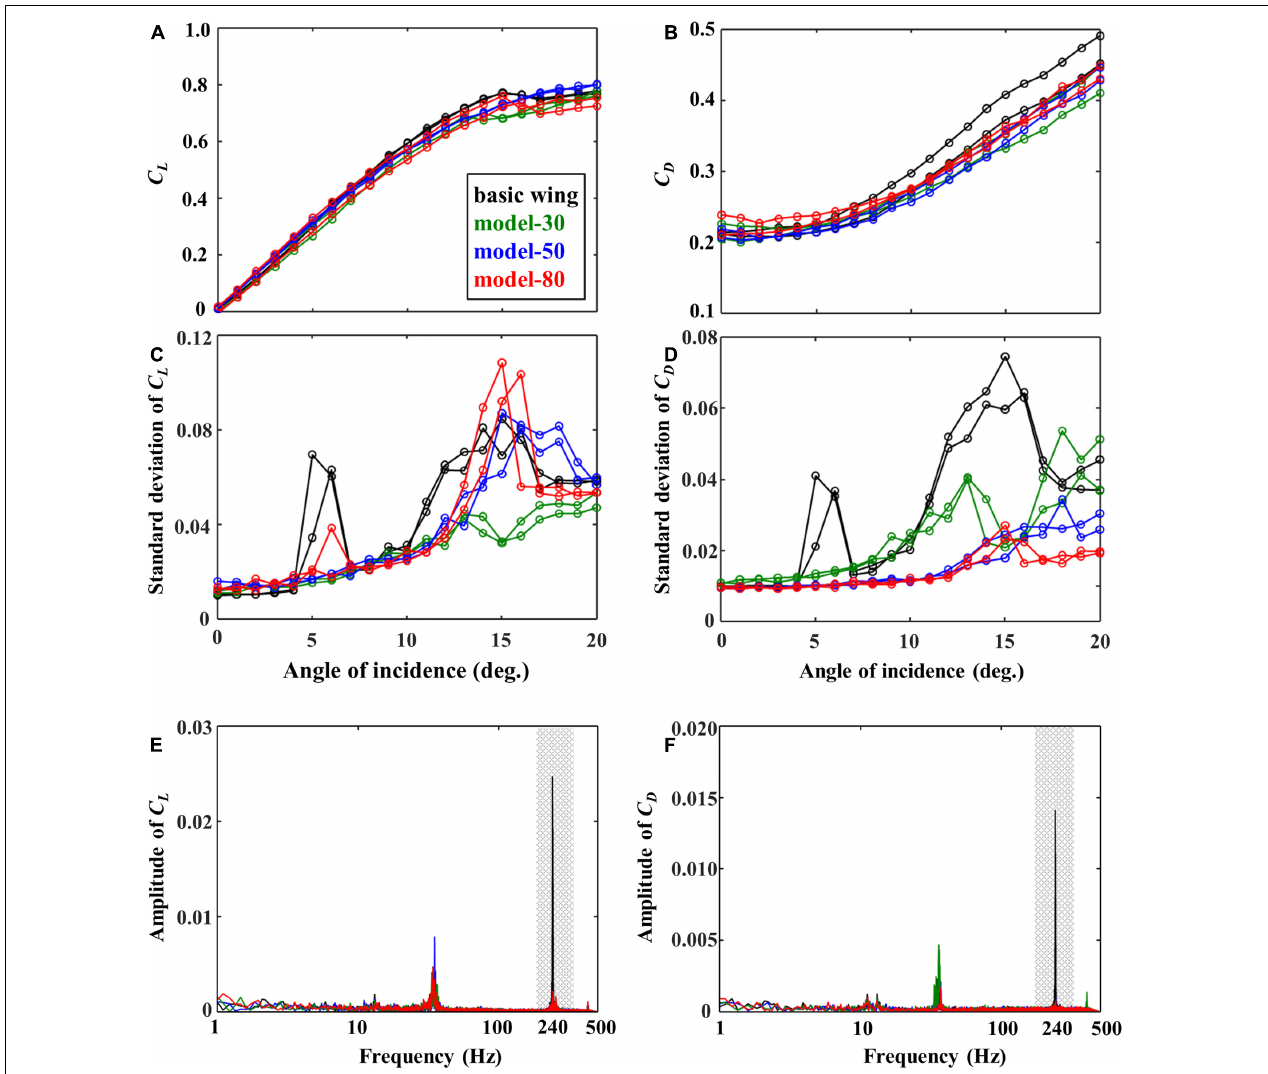
FIGURE 4 | (A) Mean lift and (B) drag coefficients ( C L , C D ), the standard deviations of panel (C) lift and (D) drag coefficients, and the frequency spectra of panel (E) lift and (F) drag coefficients at an angle of incidence of 6